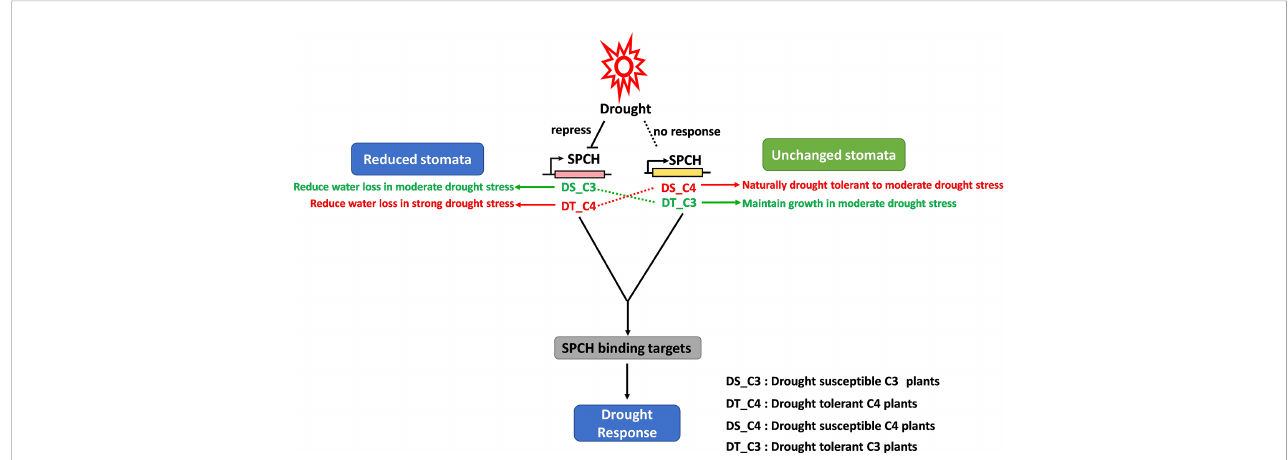
FIGURE 6 The proposed stomatal response to drought stress regulated by the divergent expression of SPCH in C3 and C4 plants. Drought repressed the expression of the SPCH of C3 plants but had no effect on that of C4 plants, resulting in the reduction of stomata in C3 plants, and no change in stomata in C4 plants in response to drought stress. However, drought-tolerant C3 plants showed no stomatal response to drought due to the stabilized expression of SPCH under drought stress. Conversely, drought-tolerant C4 plants were able to reduce the production of stomata and limit the water loss due to the re-activation of SPCH response to